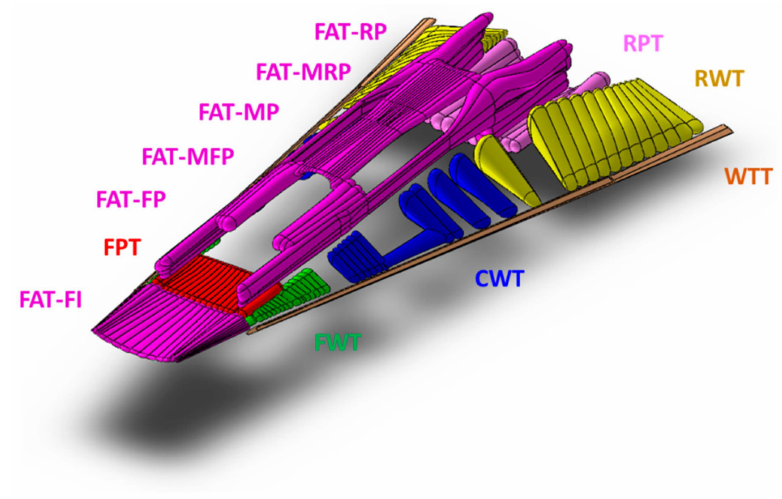
Figure 5. STRATOFLY MR3 LH2 tank architecture